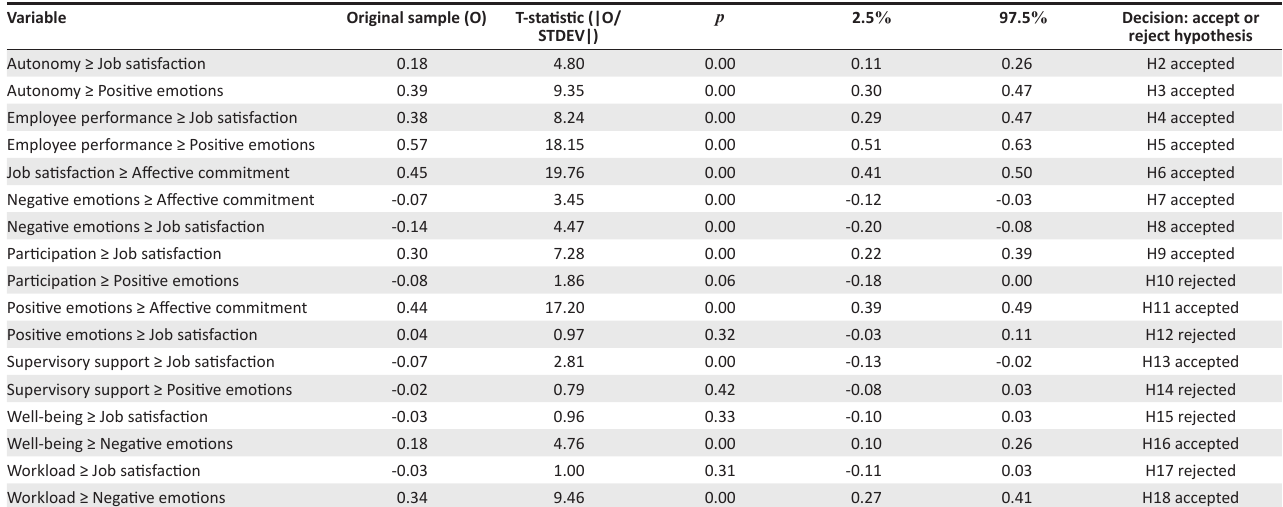
TABLE 5 : Direct effects.